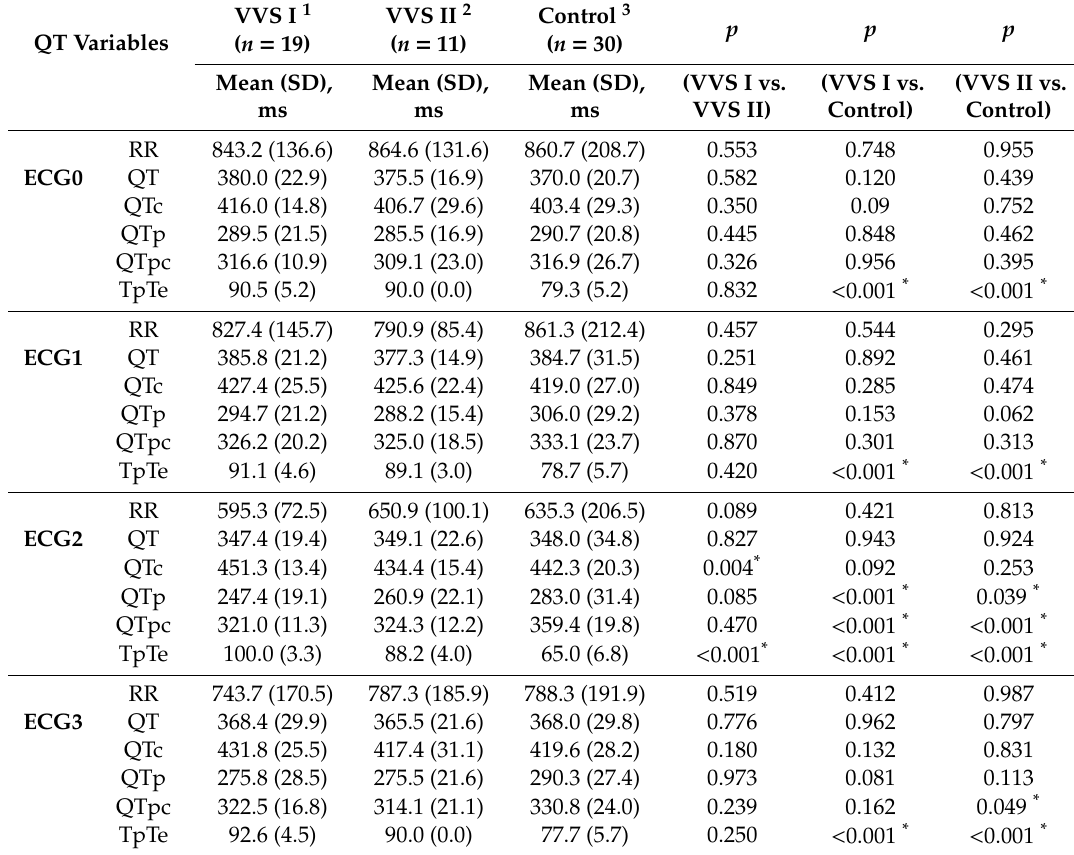
Table 2. Variations in repolarization parameters in children with vasovagal syncope, either with morphological changes on the electrocardiogram or without, compared to those with psychogenic pseudosyncope